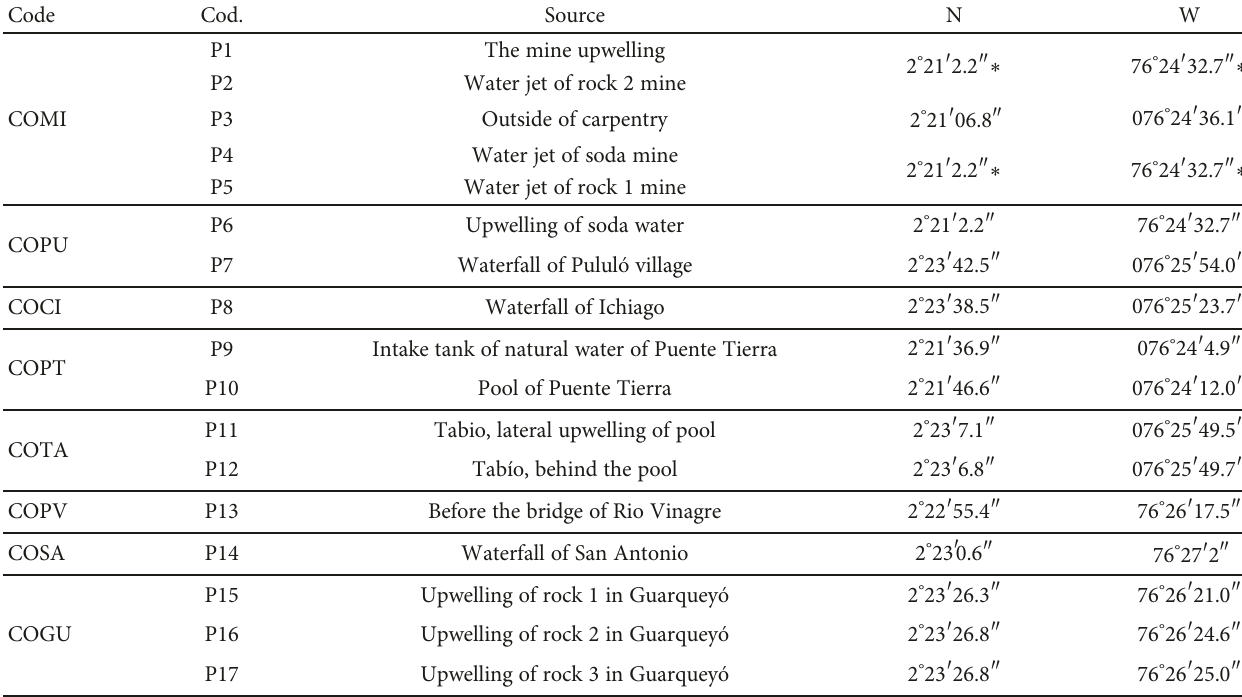
Table 1: Points of the Puracé-La Mina sector.